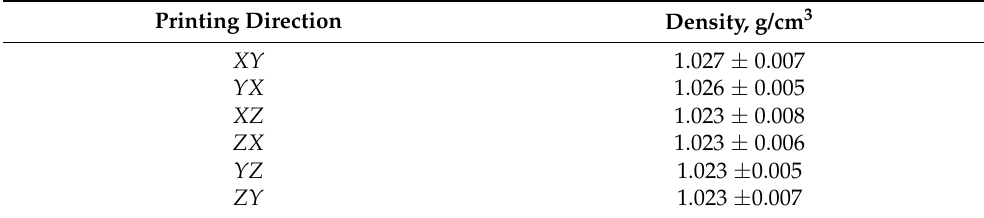
Table 2. Density of the samples printed in different